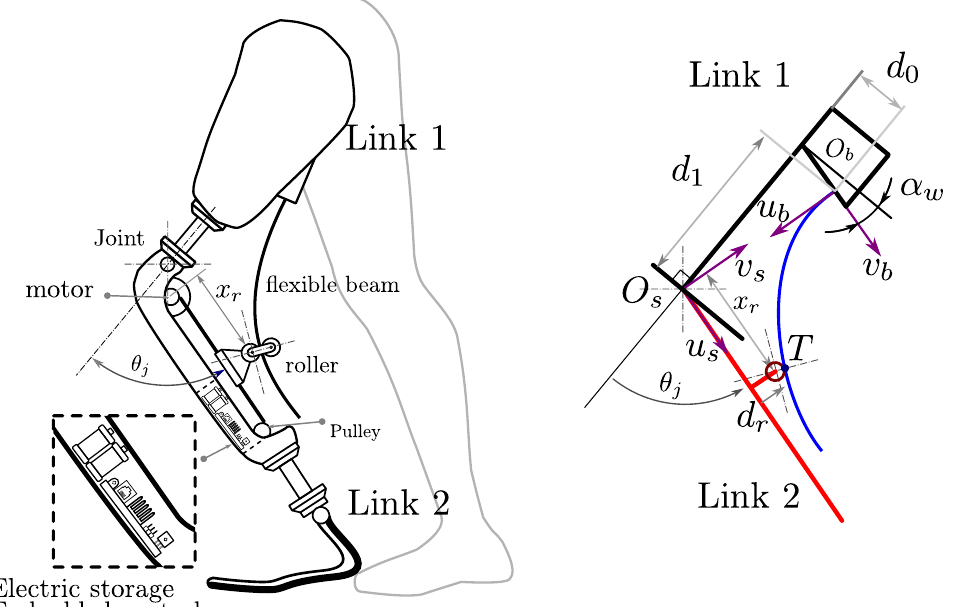
Figure 1. ( a ) General schematic of the proposed variable-stiffness actuator (VSA) design in a prosthetic leg application. ( b ) Geometry used for mechanism